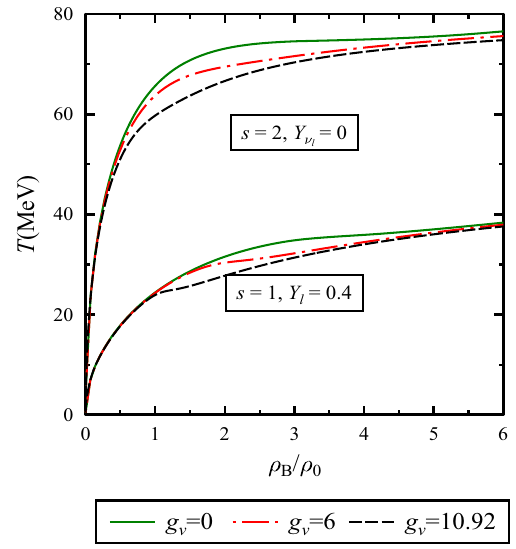
Fig. 4 The range of temperature achieved as a function of baryonic density for s = 1, 2 with/without trapped neutrinos at different vector interaction MeV, it is attained that c 2 shows decrement and for T = 80 s almost disappears. The results for the MeV, the peak of c 2 s square of the sound velocity plotted here resemble the results predicted in the three flavor NJL model [48]. density at finite temperatures is depicted in Fig. 3b, without trapped neutrino matter. At finite temperature, entropy